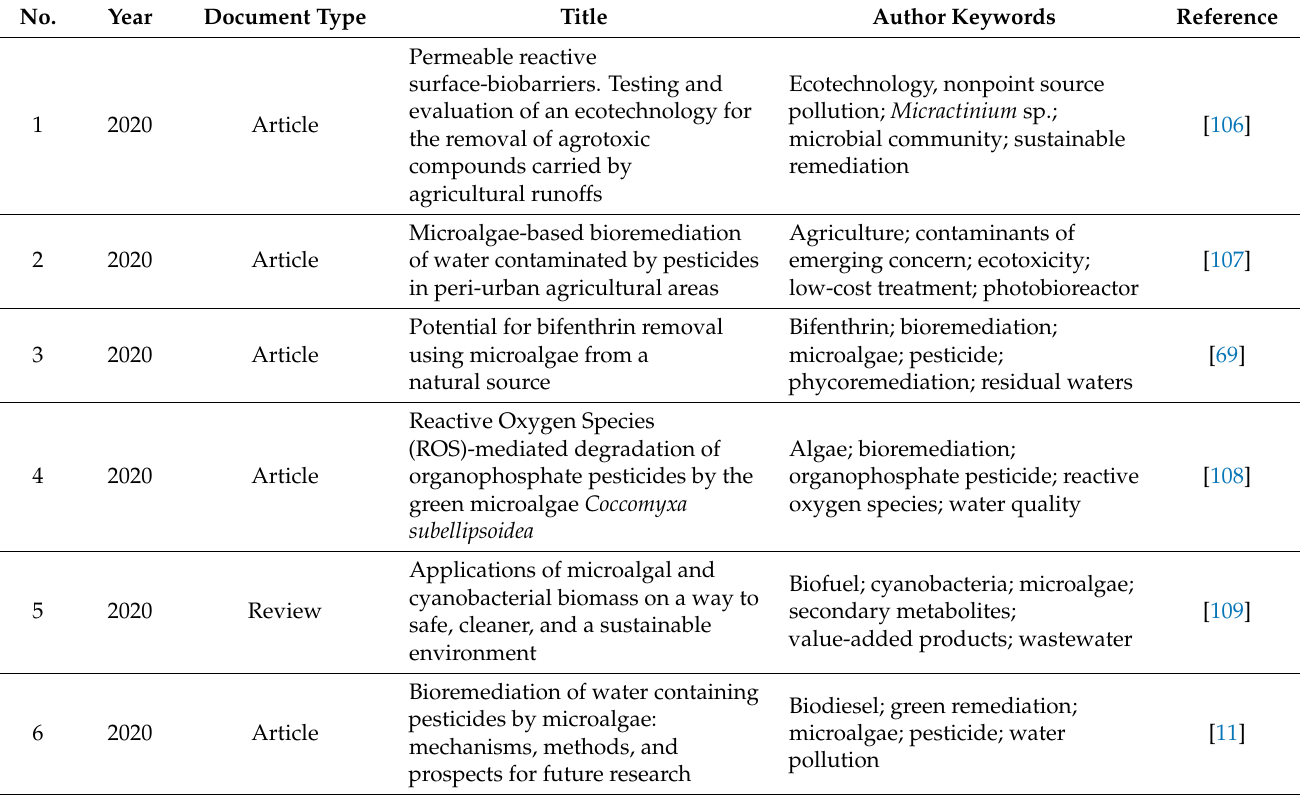
Figure 2. Annual research publication trends from 1994–2020 for both PubMed and Scopus database. Table 4. List of documents retrieved from the Scopus database between 2010 and 2020.